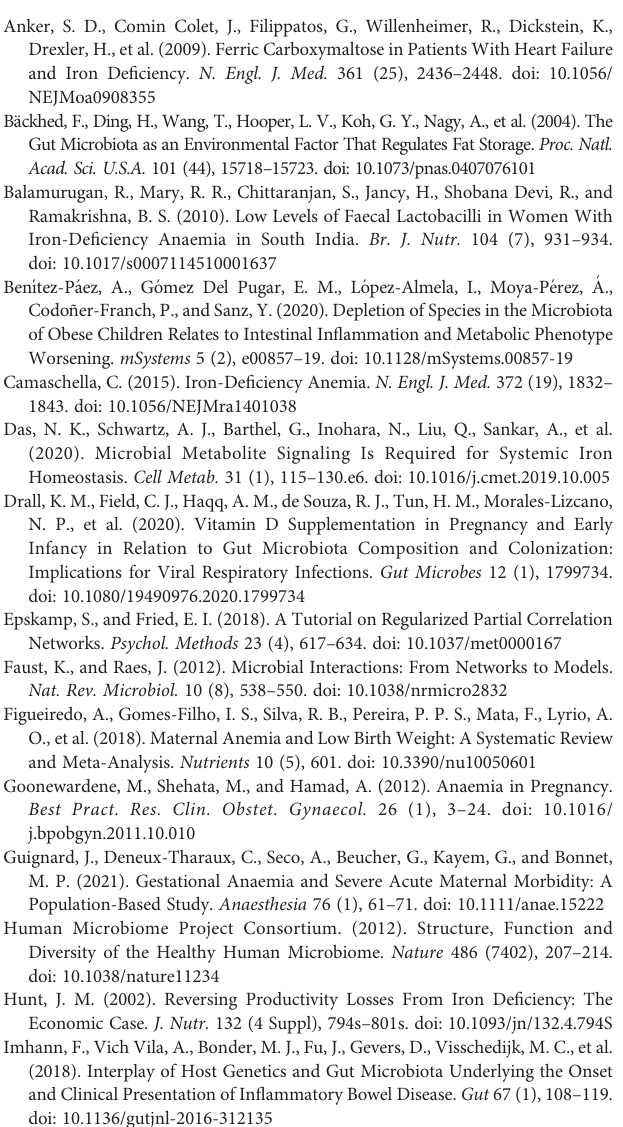
Supplementary Figure 2 | (A) Relative proportions of bacterial phyla in GA and healthy control in the third trimester. (B) Histogram of the LDA scores computed for differentially abundant taxa between GA and healthy control in the third trimester. GA, gestational anemia; LDA, linear discriminant analysis; *Genera remained signi fi cantly associated with GA after adjusting for covariates using multivariate association with linear models algorithm